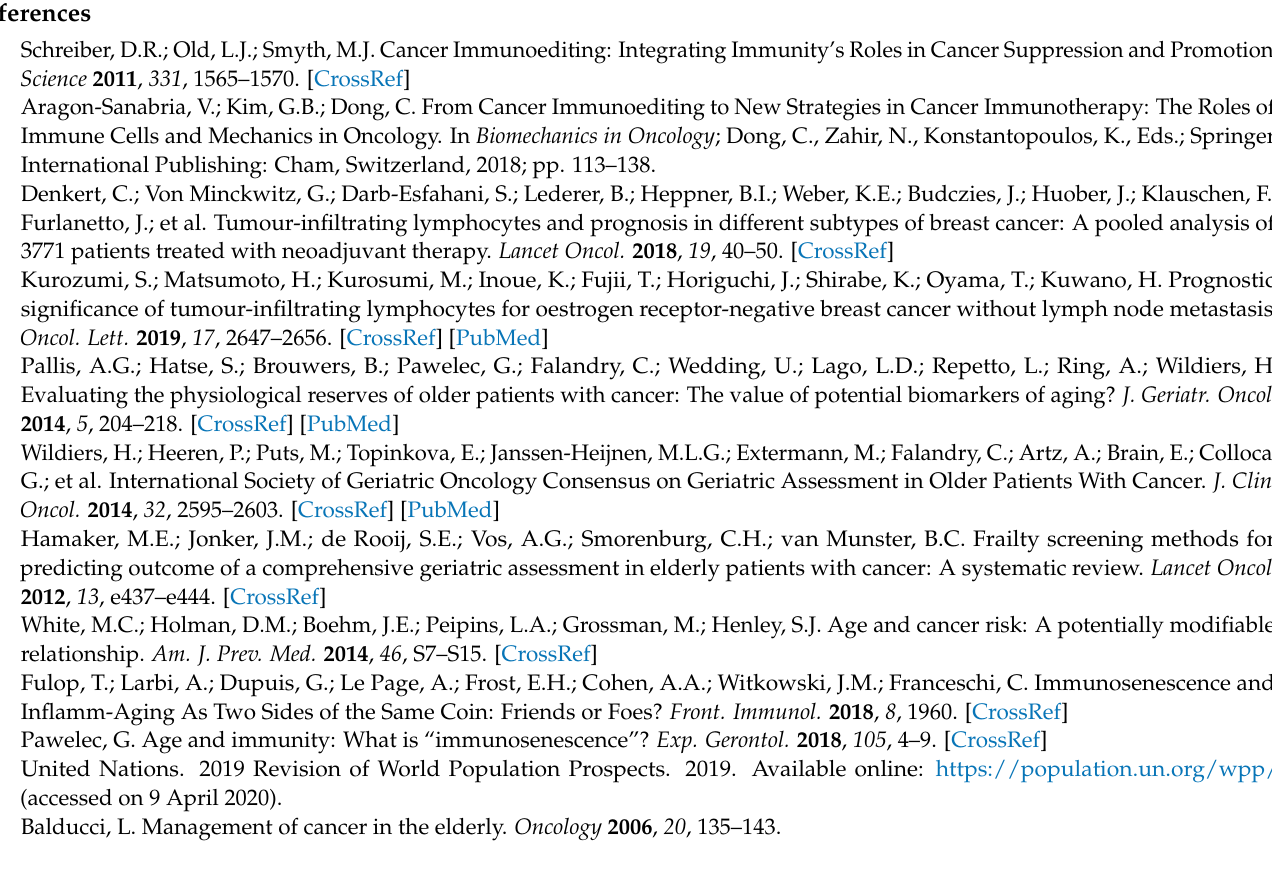
mance_frailty, Table S3: Individual performance_TILs, Table S4: Individual performance_CD3 infiltration whole tumor, Table S5: Individual performance_CD3 infiltration invasive front, Table S6: Individual performance_CD8 infiltration whole tumor, Table S7: Individual performance_CD8 infiltration invasive